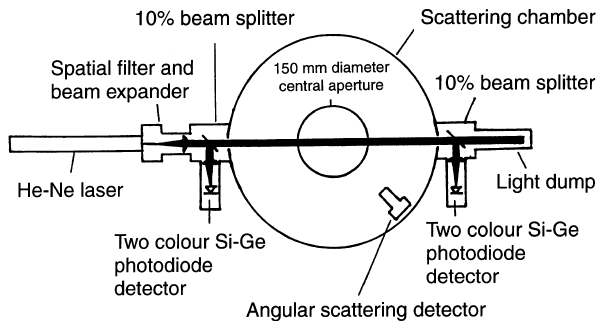
Fig. 2. Plan view of the scattering and extinction instrumentation